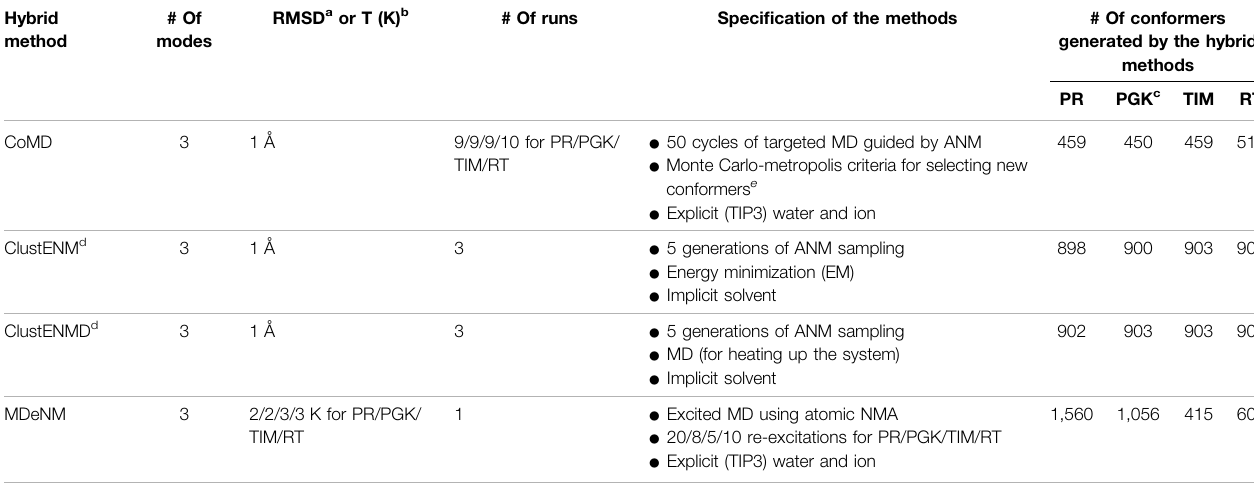
TABLE 2 | Parameters, protocols, and outputs of investigated hybrid